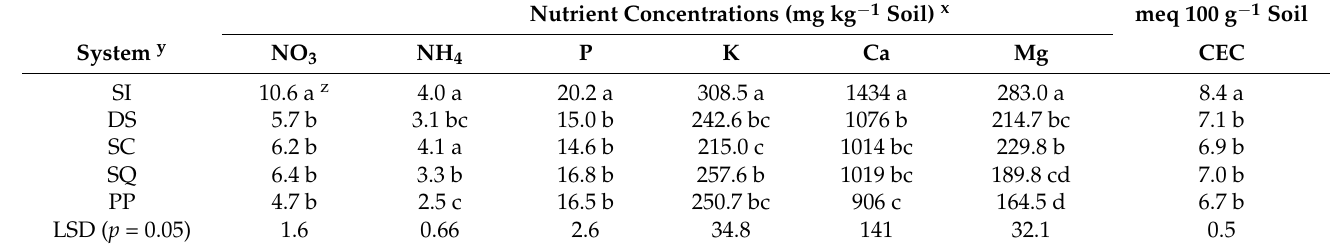
Table 7. Effect of different cropping systems on soil chemical properties, including NO3-N, NH4-N, P, K, Ca, Mg, Mn concentrations, and cation exchange capacity (CEC) from combined data over three cropping seasons (2016–2018).